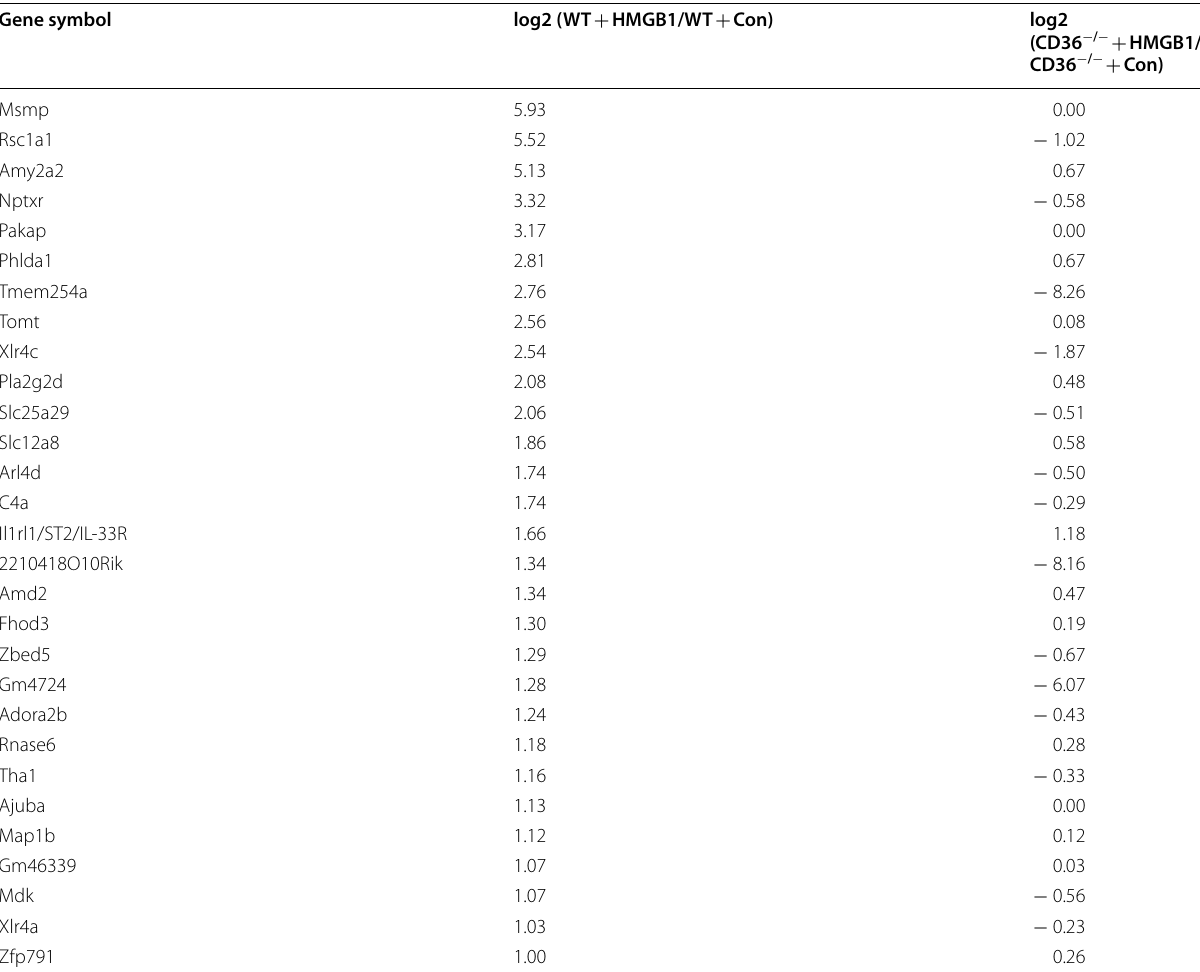
Table 1 The list of RNAs upregulated in HMGB1-treated WT BMDM, not in CD36 − / − BMDM Gene symbol log2 (WT